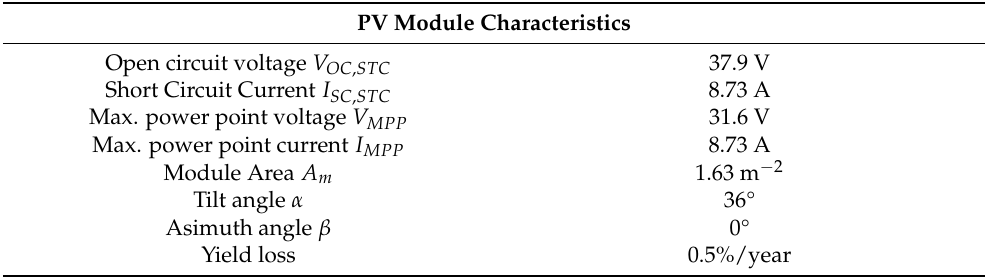
Table 1. PV module